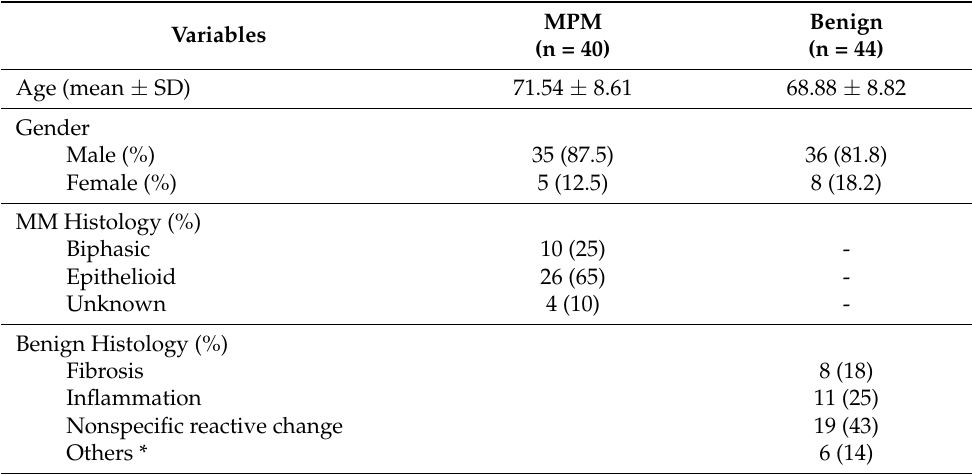
Table 1. Patient